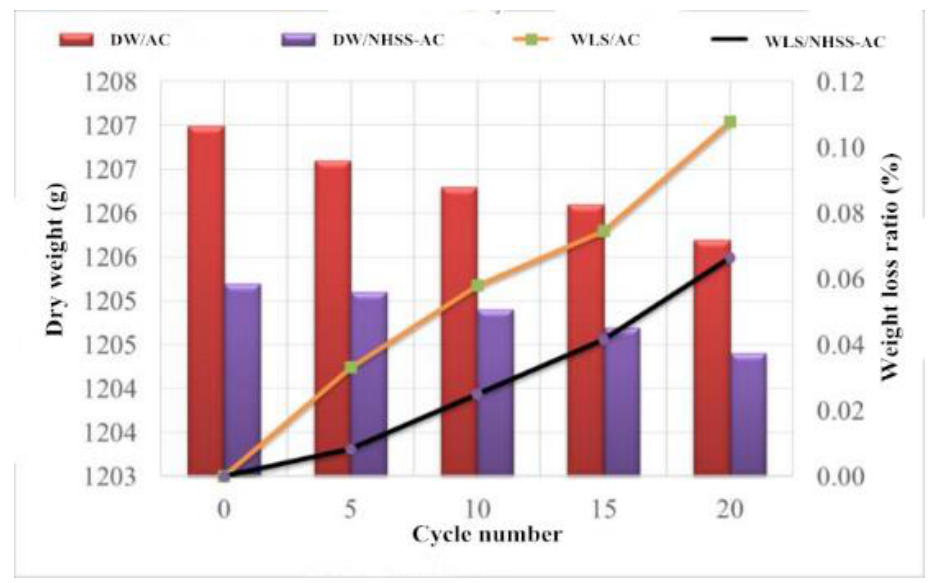
Figure 7. Weight loss ratio changes of mixtures under freeze – soak – scour cycles.